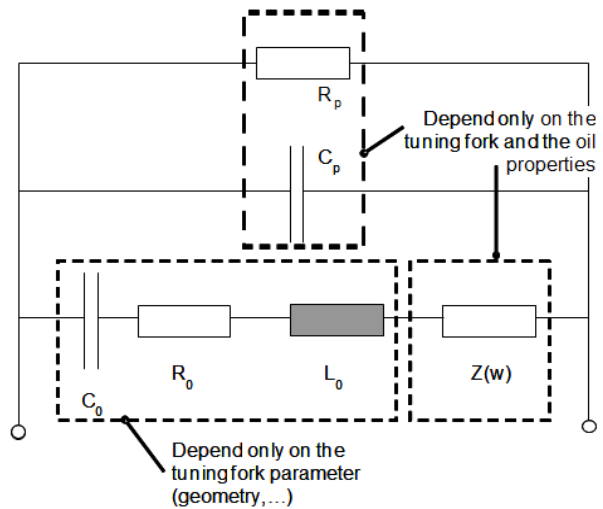
Figure 5. Tuning fork equivalent electrical model.